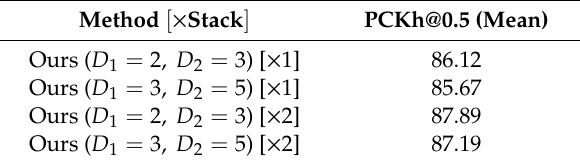
Table 4. Comparison of di ff erent dilation scales with the MPII validation